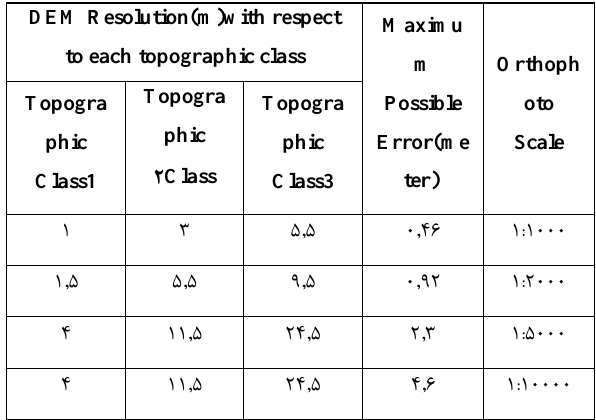
Table2. Calculated suitable DEM resolution for each scale of